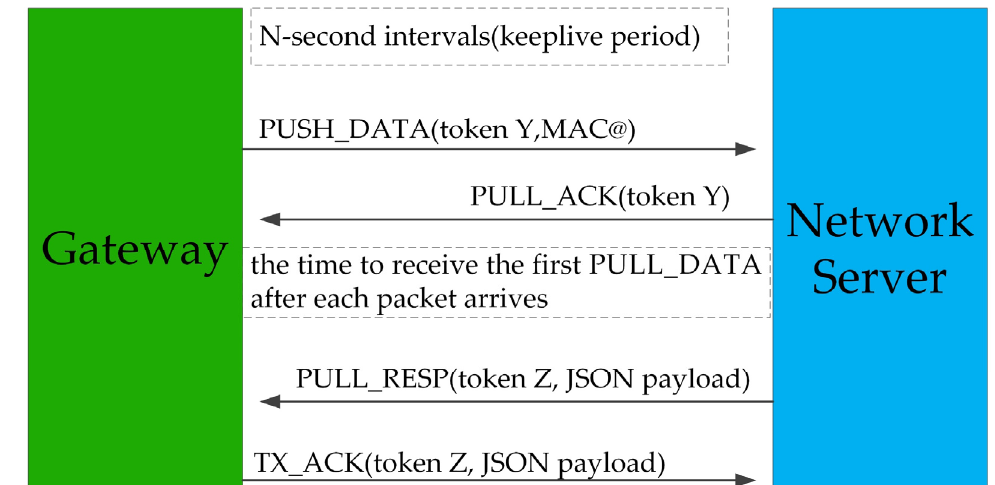
Figure 3. Gateway and server downlink communication protocol.